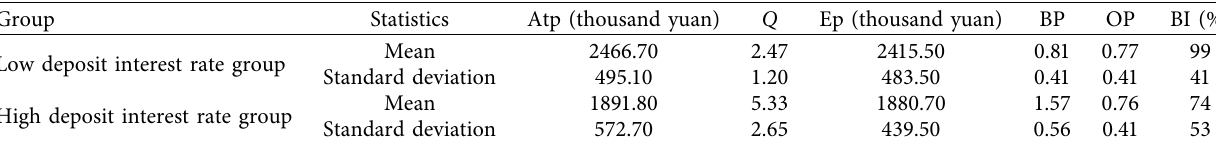
Table 5: Descriptive statistics of deposit interest rate